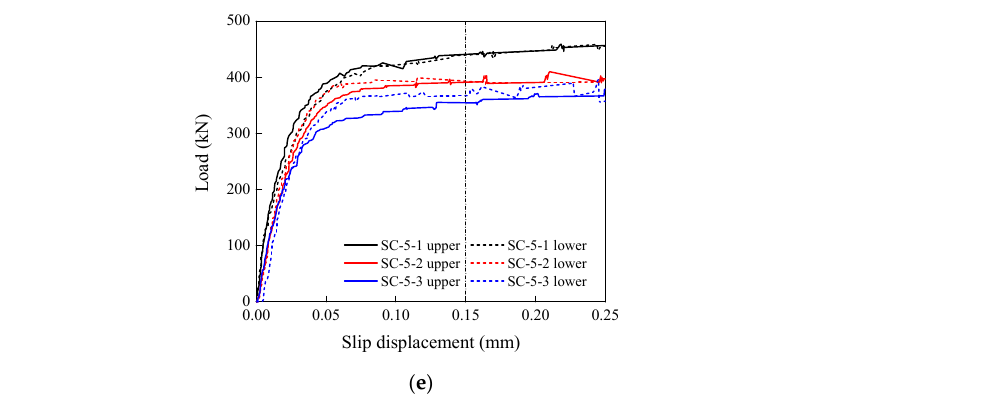
Figure 7. Abrasion around the bolt hole after the tests. ( a ) Inner plate (HVOF-coated). ( b ) Cover plate (grit-blasted).